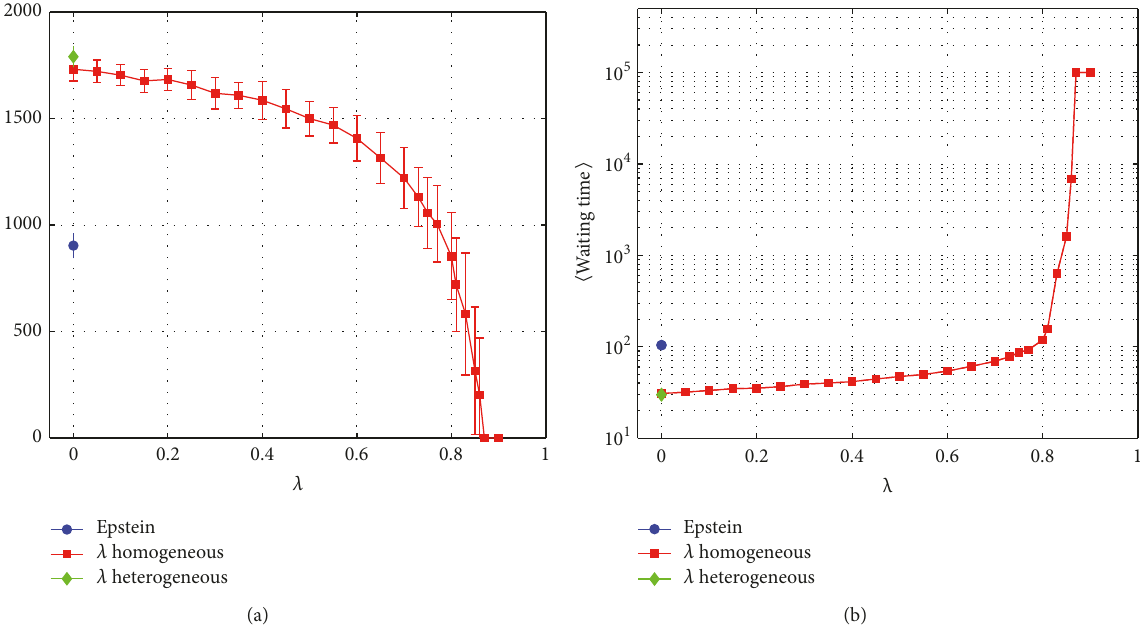
Figure 4: (a) The outburst quantity is plotted according to the saving parameter. With the line with red squares, the outburst quantity is graphed.ThebluecirclecorrespondstothevalueobtainedwiththeEpsteinmodel,whilethegreendiamondcorrespondstothevalueobtained for the case with heterogeneous savings. (b) The waiting times are plotted according to the saving parameter. The line with red squares shows the time between each outburst for homogeneous 𝜆 . The blue circle corresponds to the value obtained with the Epstein model and the green diamond corresponds to the value obtained for the case with heterogeneous